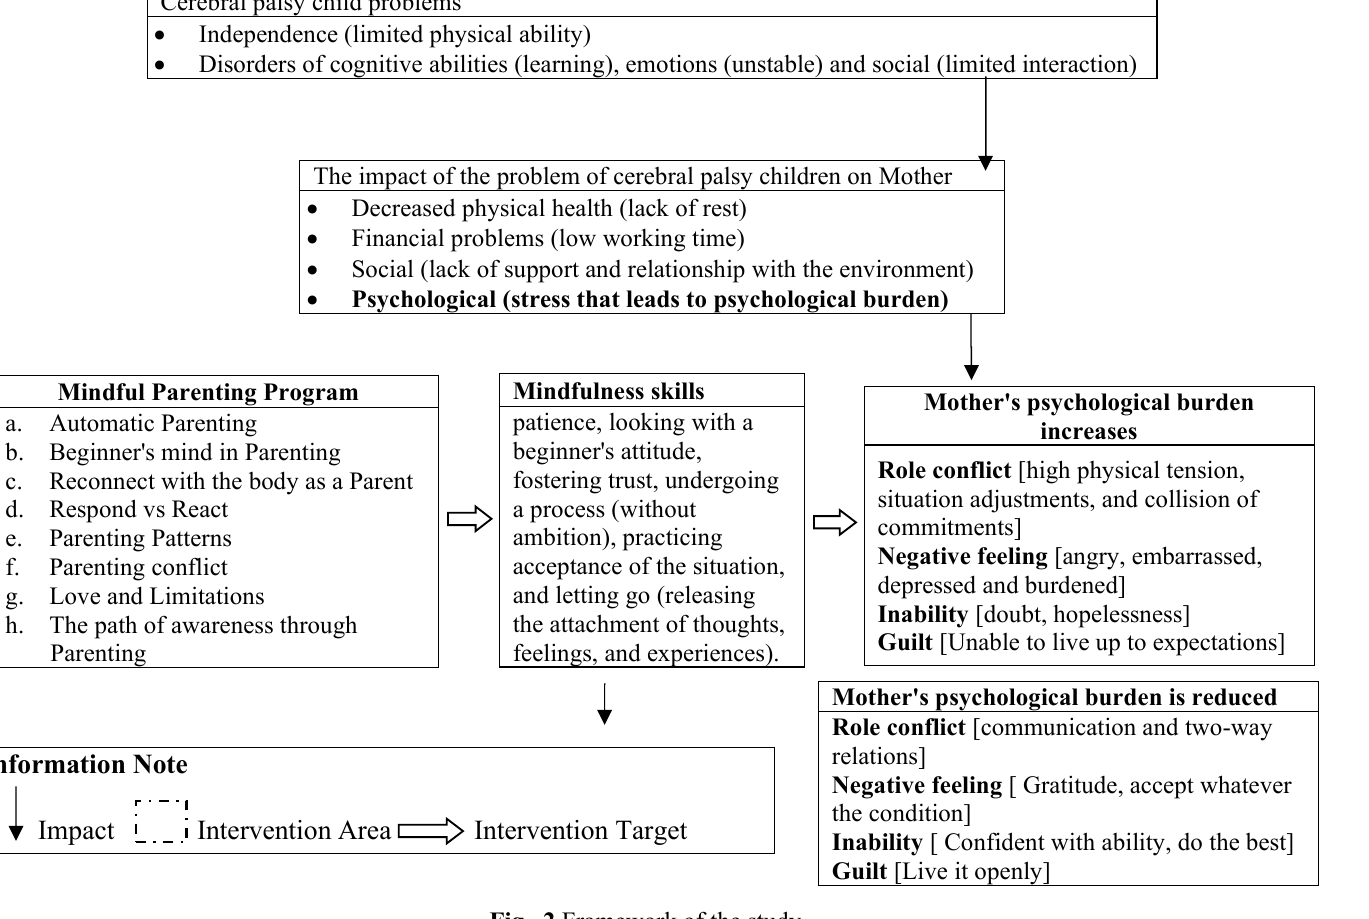
Fig. 2 Framework of the